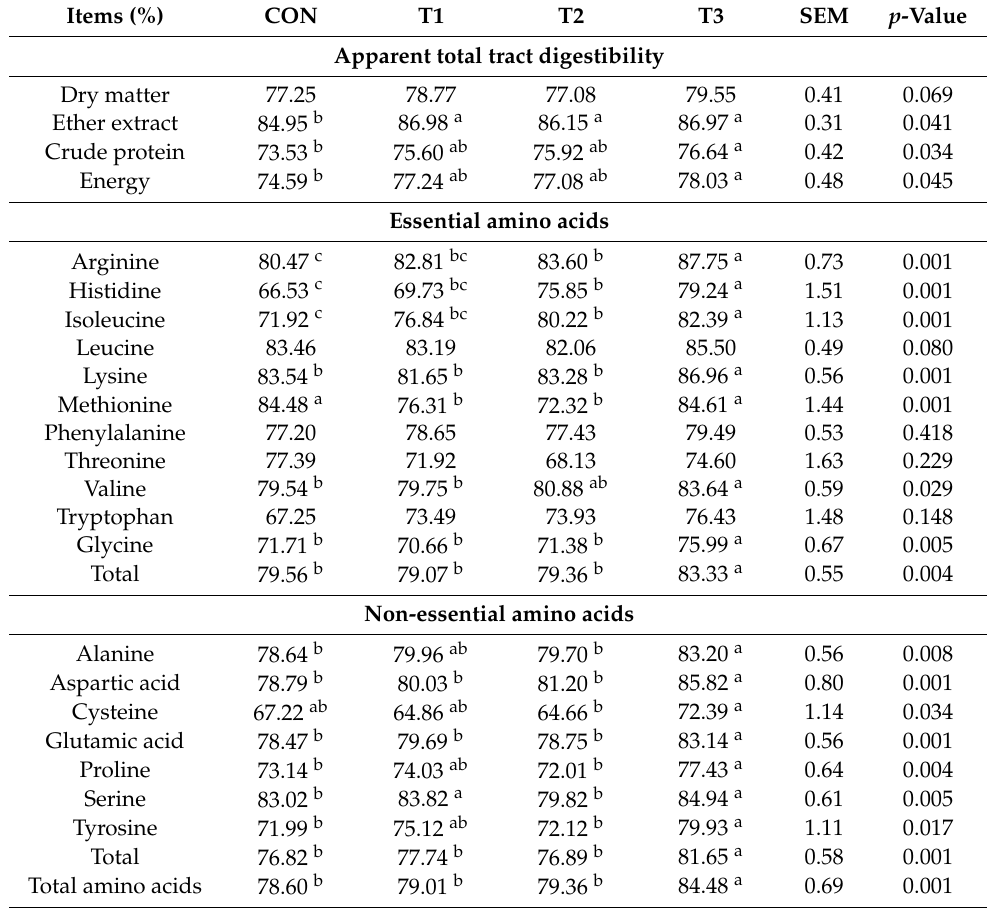
Table 8. Effects of full-fat almonds on ATTD of nutrient and amino acids in 28 days broiler chickens.